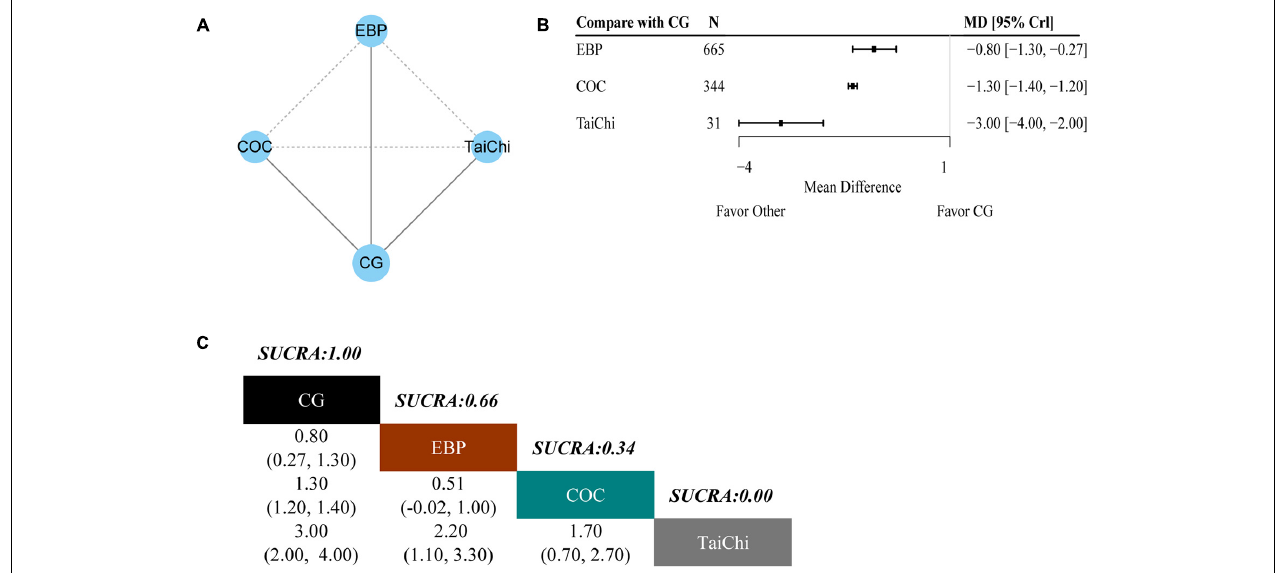
FIGURE 4 | Results of the network meta-analysis for PHQ-9. (A) Network geometry of eligible comparisons for PHQ-9. (B) Forest plot of the network meta-analysis compared with control group. (C) Ranking of each intervention based on the SUCRA values and the league table for the relative effects of all treatments. EBP, email-based promotion; COC, collaborative care; CG, control group; SUCRA, surface under the cumulative ranking curve; MD, weighted mean difference; CrI, credible interval.